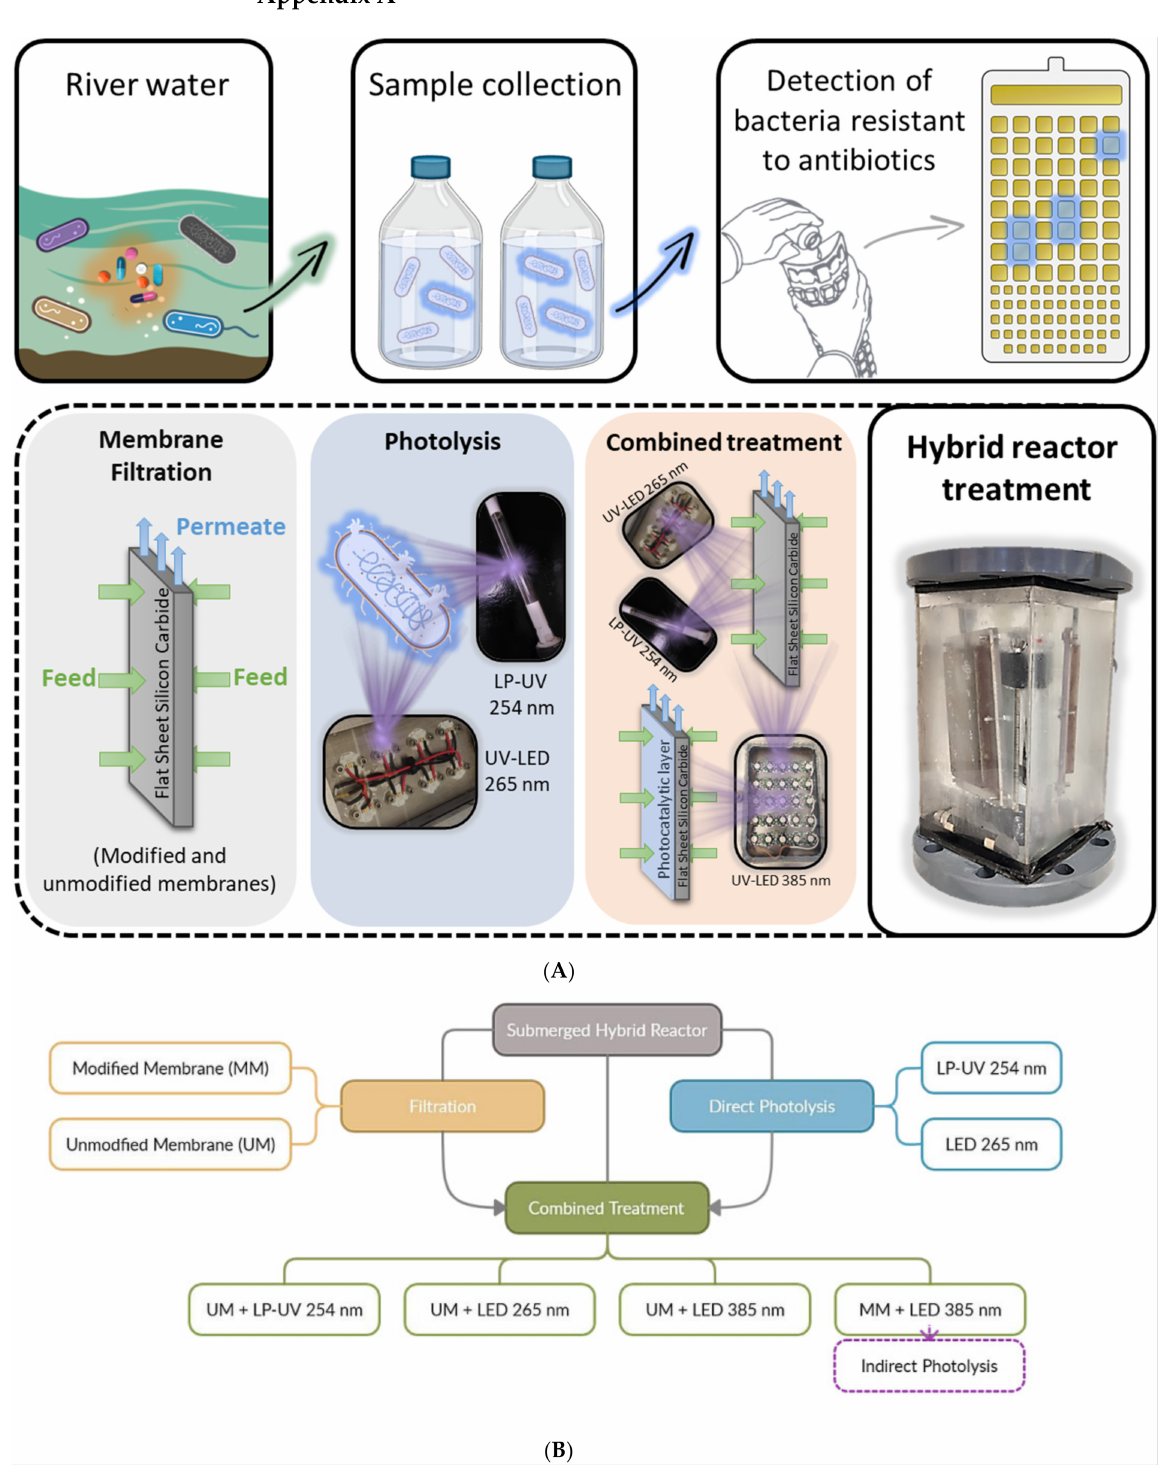
Figure A1. Graphical abstract ( A ) and diagram of the experiments conducted in the submerged hybrid reactor ( B